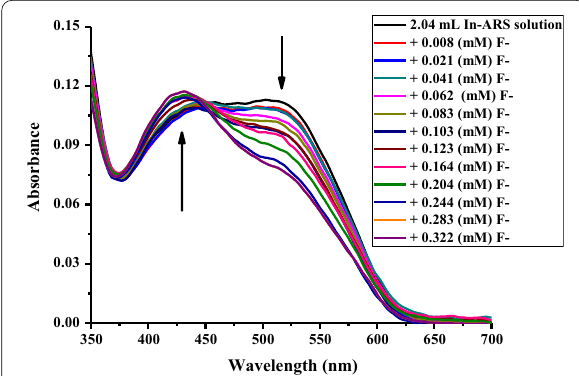
Fig.3 Absorption spectral change for the sensing of F